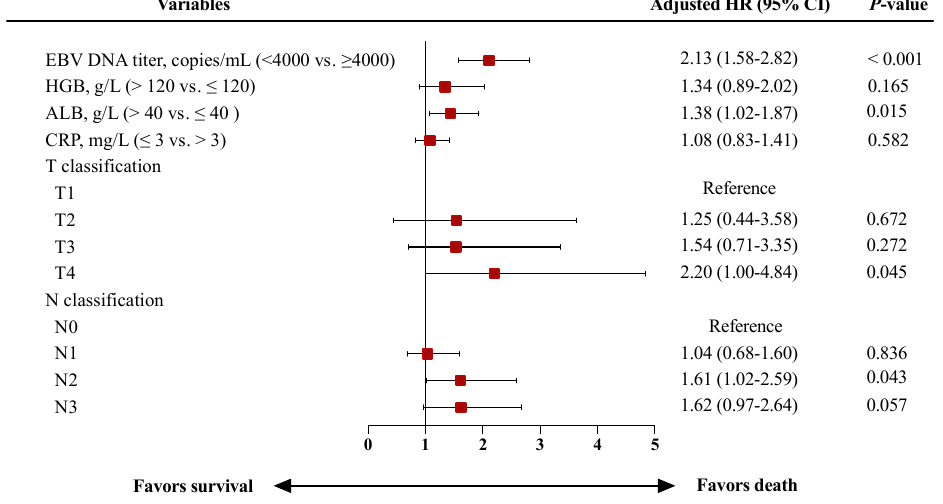
Figure 1. Forest plot shows the results of the multivariate analysis for DFS in elderly patients with LA-NPC. Red squares indicate HRs and horizontal bars indicate 95% CIs. LA-NPC, locoregionally advanced nasopharyngeal carcinoma; EBV, Epstein–Barr virus; DNA, deoxyribonucleic acid; HGB, hemoglobin; ALB, albumin; CRP, C-reactive protein; HR, hazard ratio; CI, confidence interval. DFS, disease-free survival.